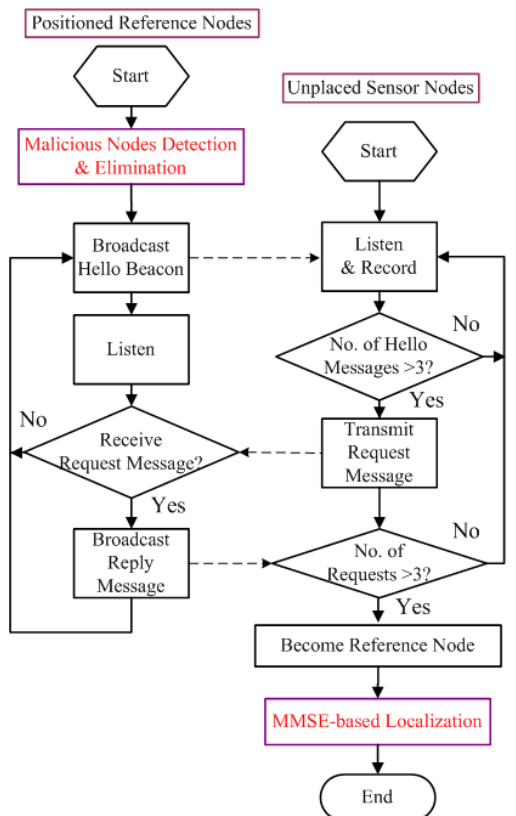
Figure 4. Flow chart of iterative localization method. MMSE = Minimum Mean Squared